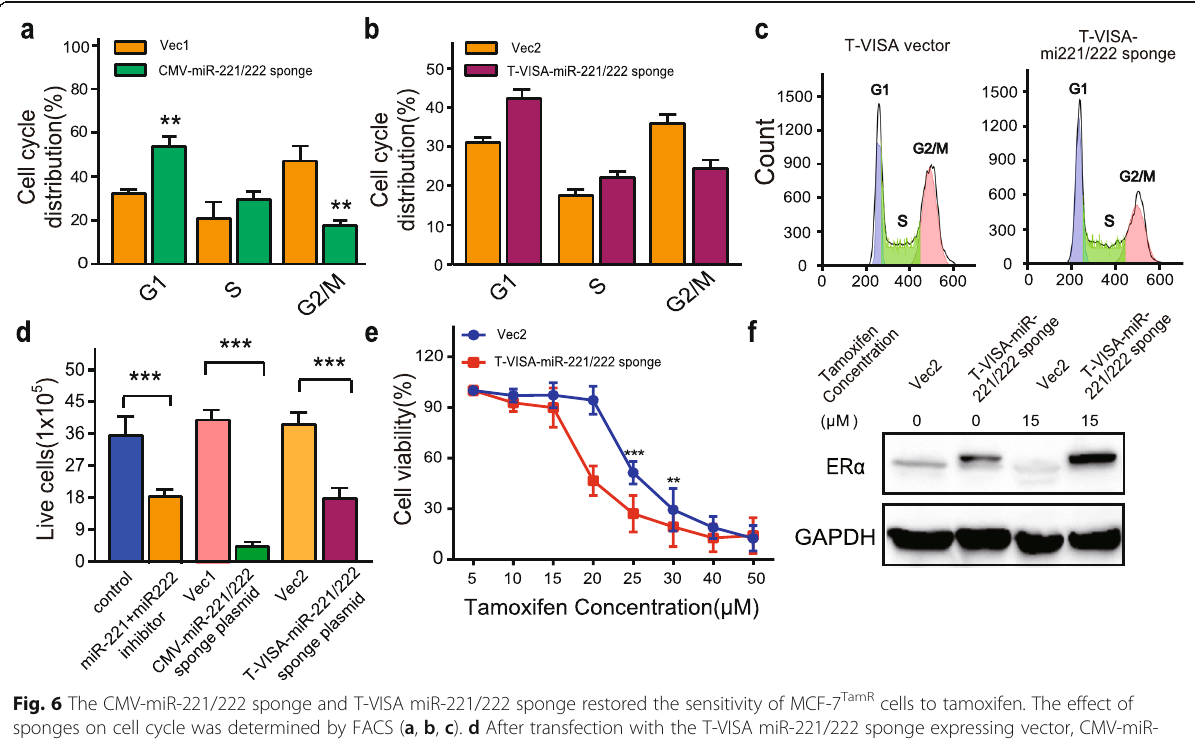
Fig. 6 The CMV-miR-221/222 sponge and T-VISA miR-221/222 sponge restored the sensitivity of MCF-7 TamR cells to tamoxifen. The effect of sponges on cell cycle was determined by FACS ( a , b , c ). d After transfection with the T-VISA miR-221/222 sponge expressing vector, CMV-miR- 221/222 sponge expressing vector or miR-221 plus miR-222 inhibitor, the growth of MCF-7 TamR cells in the presence of 15 μ M 4- hydroxytamoxifen was determined by the CCK-8 assay. e The effect of the T-VISA-miR-221/222 sponge on restoring the sensitivity of MCF-7 TamR cells to 4-hydroxytamoxifen (0 – 40 μ M) was determined using the CCK-8 assay. f The expression of ER α in MCF-7 TamR cells was analyzed by western blotting after 72 hours transfection with the T-VISA-miR-221/222 sponge expressing vector in the presence or absence of 15 μ M 4- hydroxytamoxifen. Data in a-e were presented as the mean ± SD ( n = 3). *** p < 0.001, ** p <